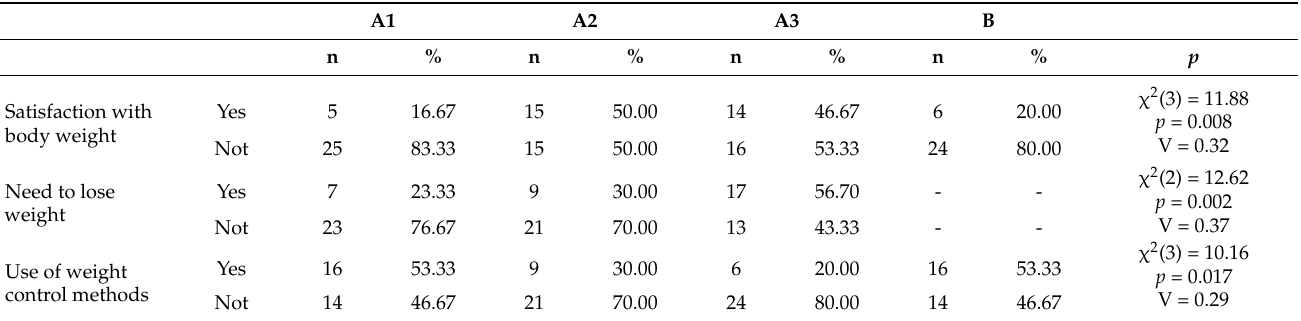
Table 6. Satisfaction with body weight and use of methods for body weight control in the studied and in the control groups.